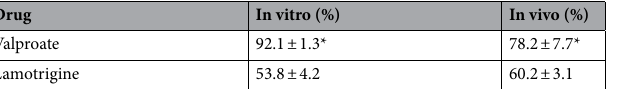
Table 2. Comparison of protein binding results from in vitro and in vivo methods. Protein-free fraction/ whole plasma concentration ratios (%) in plasma of P4 rats from experiments conducted either in vitro (spiked with valproate or lamotrigine with respective [ 3 H]-labelled drugs) or in vivo (plasma collected from animals injected with unlabelled drugs estimated by LC–MS/MS). Mean ± SD; n = 3–4. * p < 0.05.